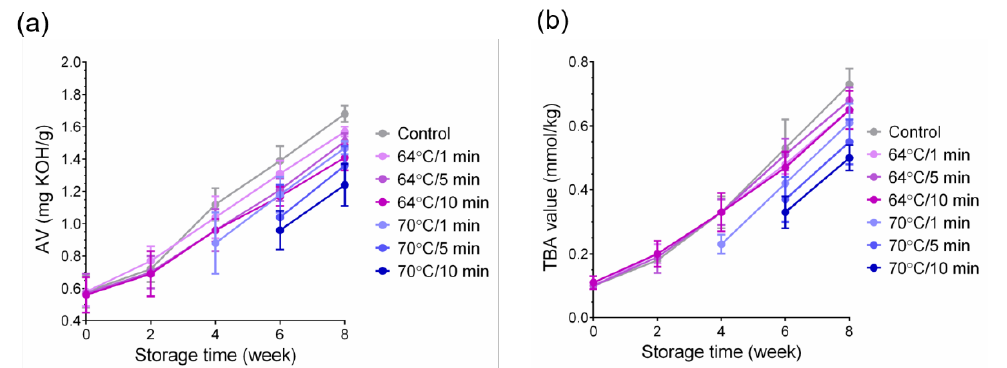
Figure 5. Changes of the acid and peroxidation (TBA) values during storage of mayonnaise products prepared from thermally processed LEY. ( a ) Acid values of temperature at 64 °C and 70 °C for 1, 5, and 10 min. ( b ) TBA values of temperature at 64 °C and 70 °C for 1, 5, and 10 min. The auto-oxidation of unsaturated and polyunsaturated fatty acids in oil is one of the causes of spoilage in mayonnaise. As a result of lipid peroxidation, emulsions that contain fats produce off-flavors and off-odors, thus reducing their shelf lives [37]. Malonaldehyde (thiobarbituric acid, TBA) and peroxide (PV) values are well-established methods to de- termine oxidation products in fats and oils (either primary or secondary products) [38].